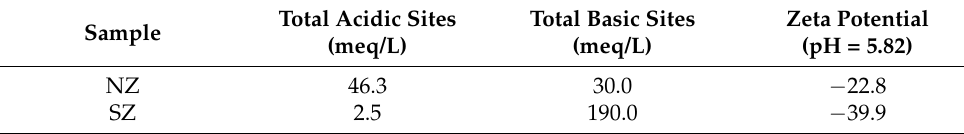
Table 3. Total acidic and basic surface sites and zeta potential of NZ and